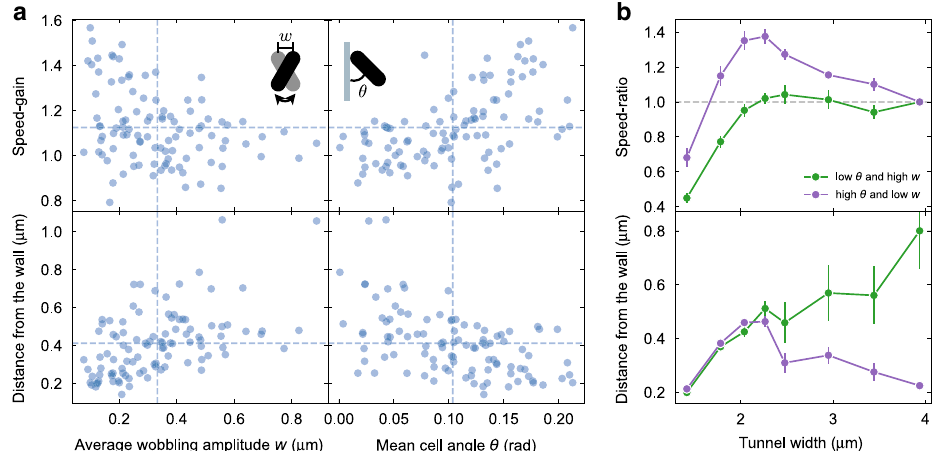
Fig. 3 Speed gain depends on swimming characteristics. a Speed gain (from 3.9 to 2.3 μ m) and wall distances versus wobbling amplitude w and pitch angle θ . Each cell appears as a point in the scatter plots. Dashed lines represent mean values. Wall distance, w , and θ are all measured in the largest tunnel (3.9 μ m). Error bars (s.e.m.) are always within the symbol size. b Cells with low w and high θ display a substantial speed increase with con fi nement (purple) which is connected to a marked increase in the distance from the wall below 2.5 μ m. The speeds are normalized to the values in the largest microtunnel. No signi fi cant speed gain is observed for cells with high w and low θ (green) for which the wall distance progressively decreases with con fi nement. Plotted error bars represent